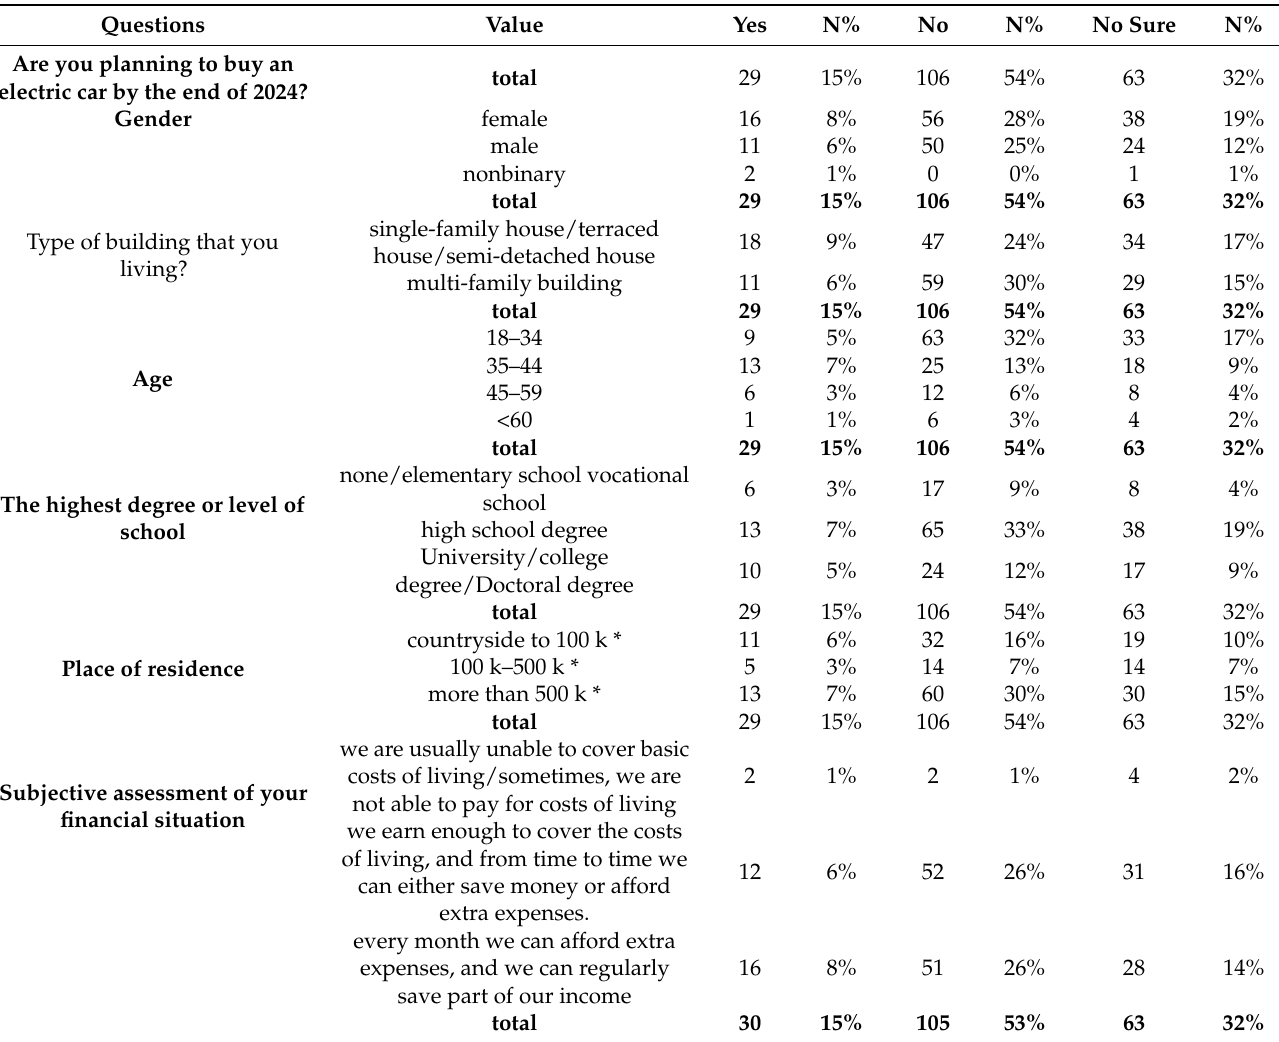
Table 7. Respondents’ stated plans to purchase an electric car for personal